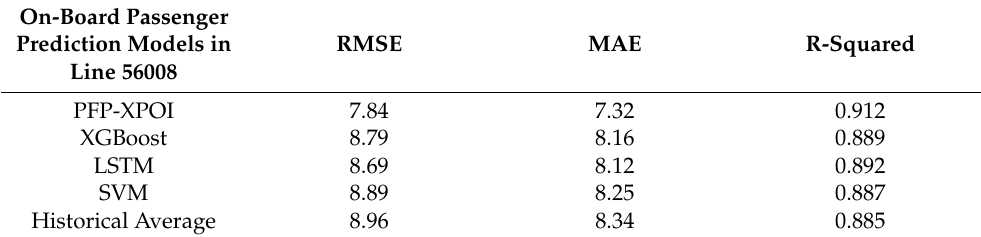
Table 2. Evaluation values of different models for on-board passenger prediction in line 56008.